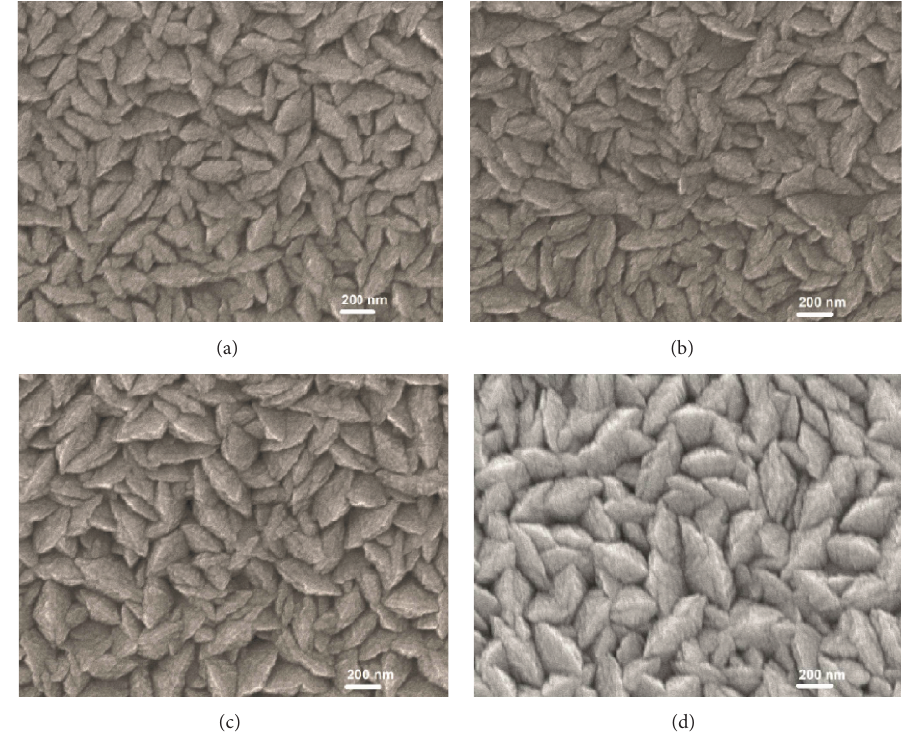
Figure 8: Surface morphology of GZO film with thickness ∼ 800nm on different ZnO buffer layer thicknesses: (a) 212 nm, (b) 422 nm, (c) 652 nm, and (d) 766 nm. The deposition temperature of GZO film was 400 ∘ C.